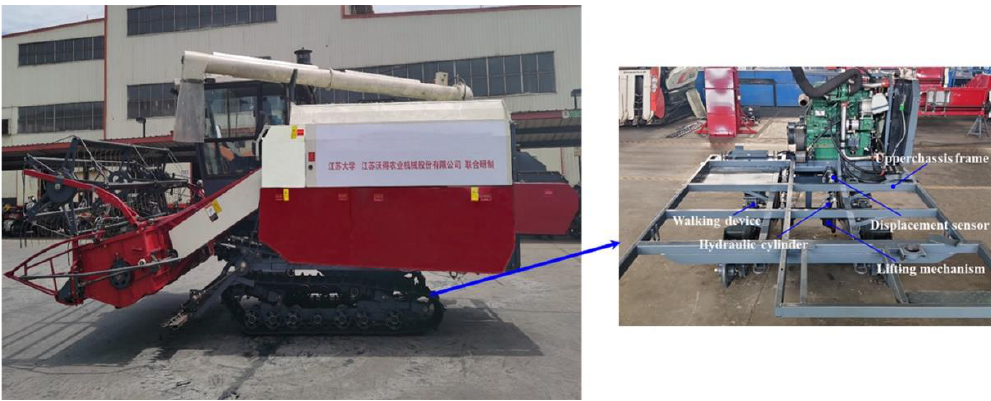
Figure 12. The prototype with the adaptive leveling system.